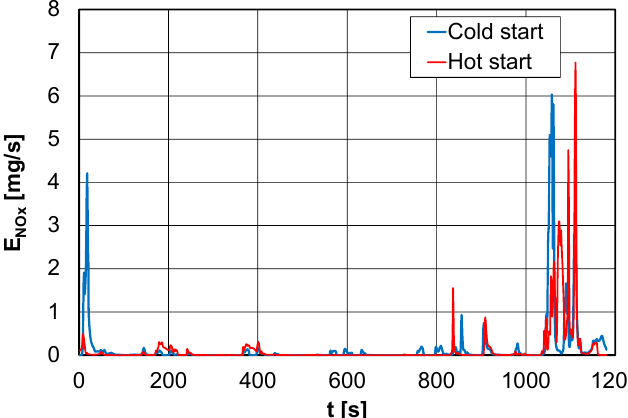
Figure 5. Nitrogen oxides exhaust emissions (E NOx ) for cold and hot engine start.